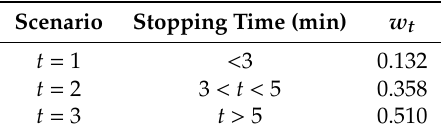
Table 1. Weights of different stopping time.